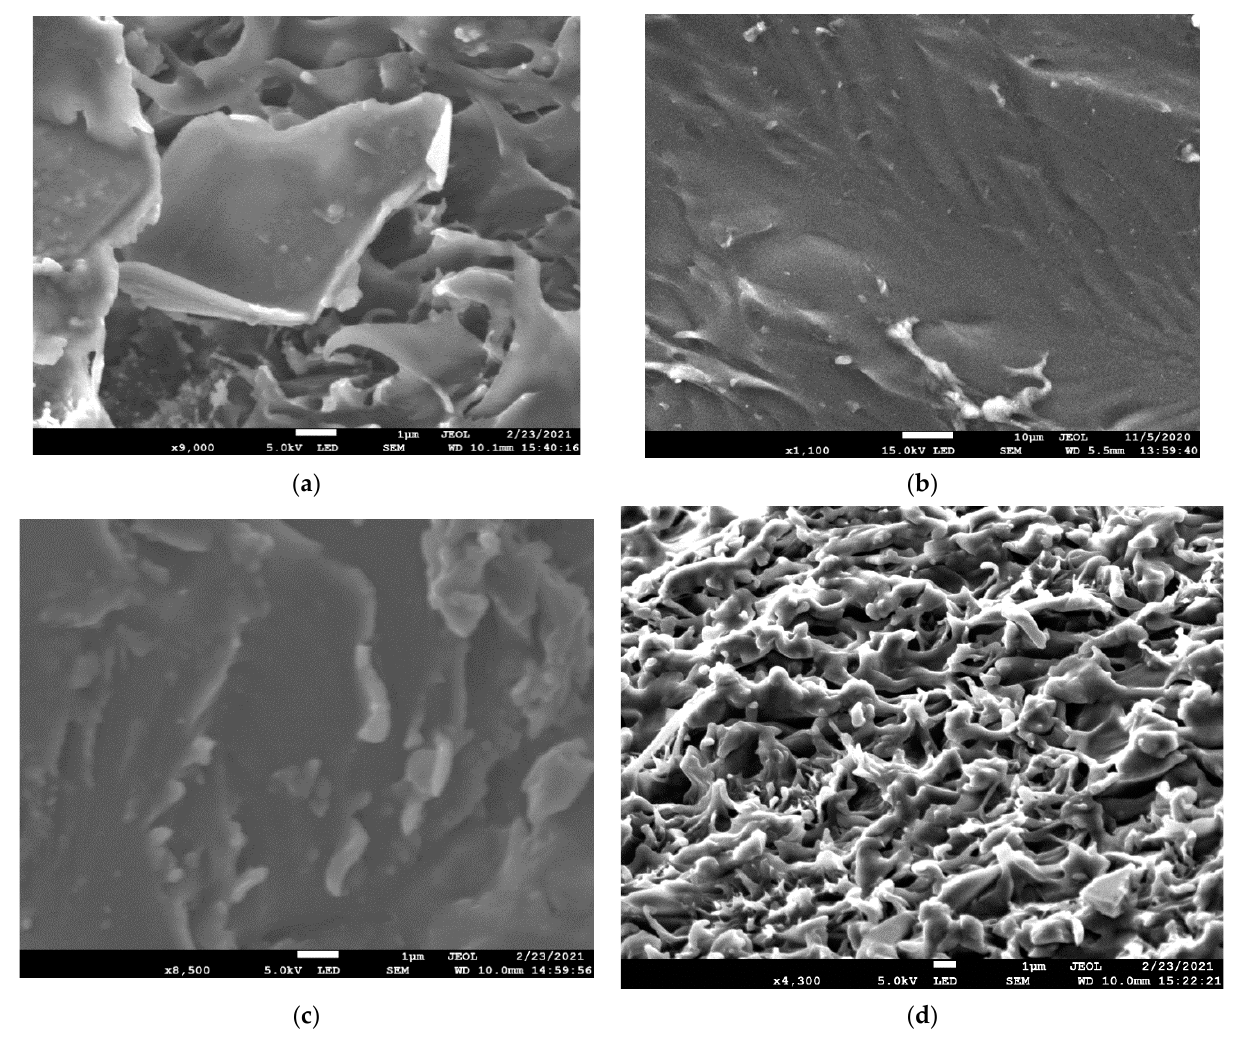
Figure 2. Cross sectional SEM images of ( a ) PVA; ( b ) PVA-GO; ( c ) PVA-CNT-COOH; ( d ) PVA-GO- CNT-COOH nanocomposite membranes.